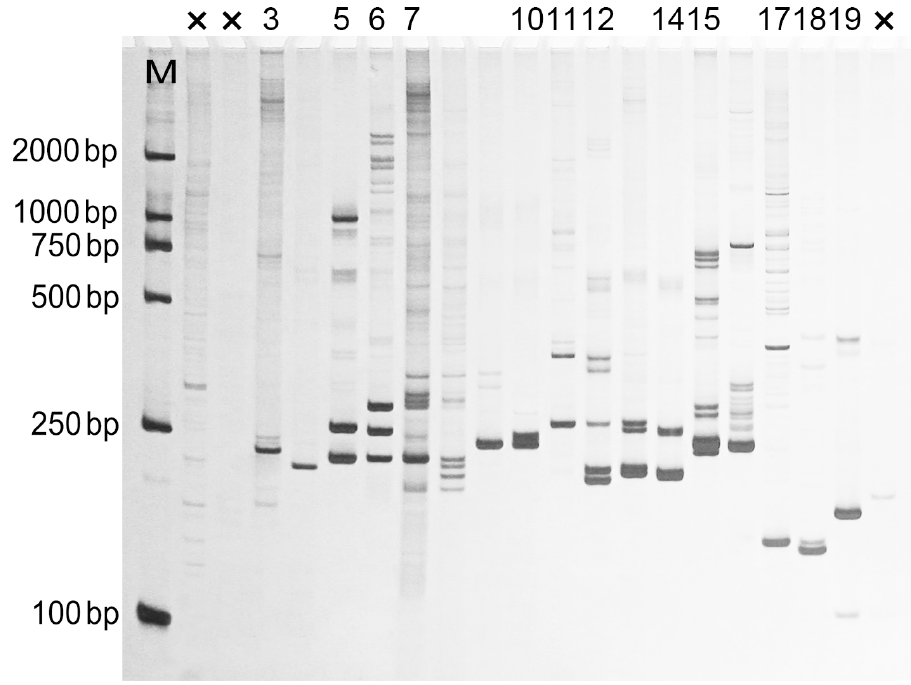
Figure 6. PCR amplification using 20 primer pairs randomly selected in P. densiflora . ”×”: void amplification. M: DNA Marker DL2000.